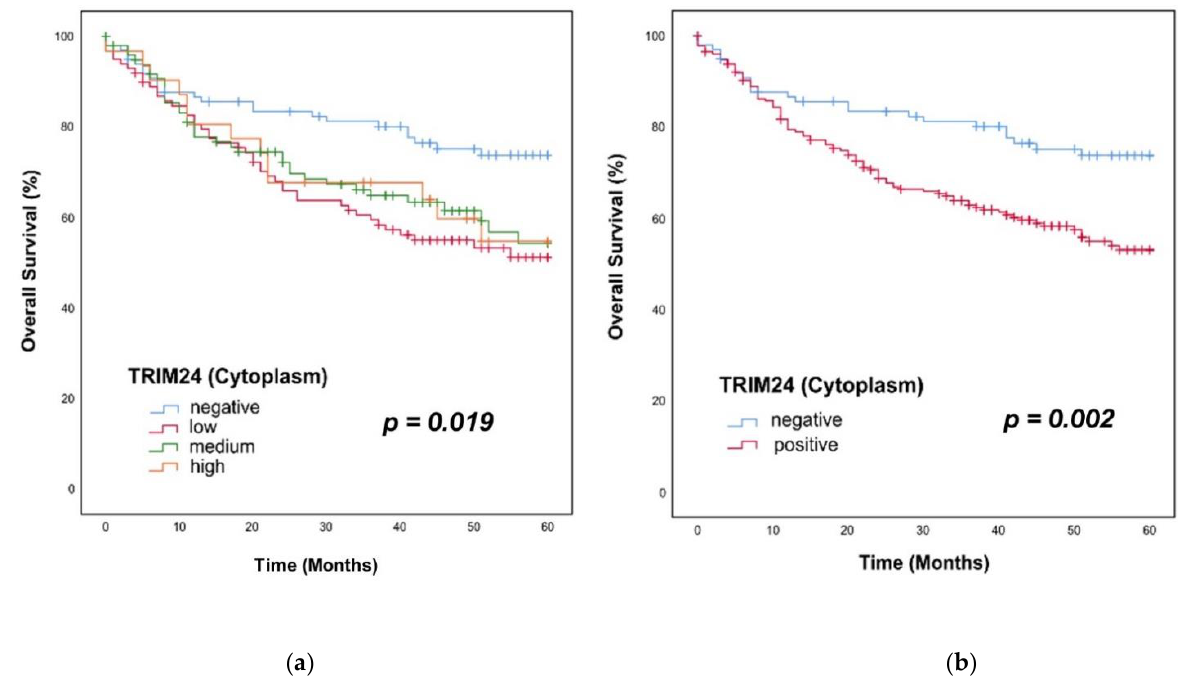
Figure 5. Kaplan – Meier analyses of TRIM24 expressing HNSCC PTs. ( a ) There is a significant difference in the OS rates over 60 months of patients with TRIM24 negative, low, medium, and high expressing PTs (log – rank test, p = 0.019). ( b ) We compared all TRIM24 expressing PTs against the TRIM24- tumors. The patients with TRIM24+ PTs show a significantly worse OS over 60 months than patients with TRIM24 − PTs (log – rank test, p = 0.002). Table 1. Univariate and multivariate cox regression for 60-months OS.